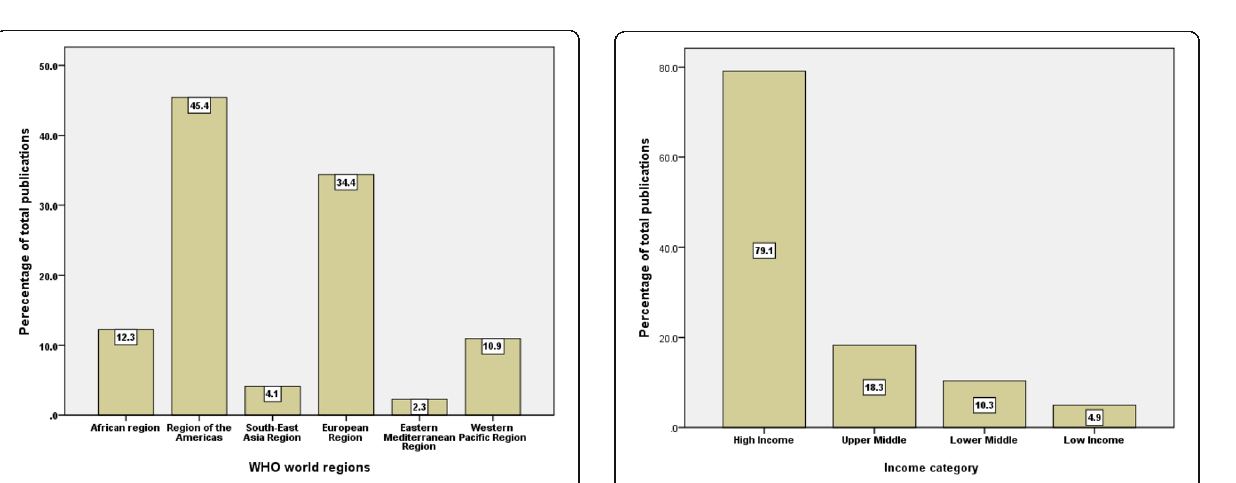
Fig. 5 Distribution of publications on HHR based on World Bank criteria for income (1900 –